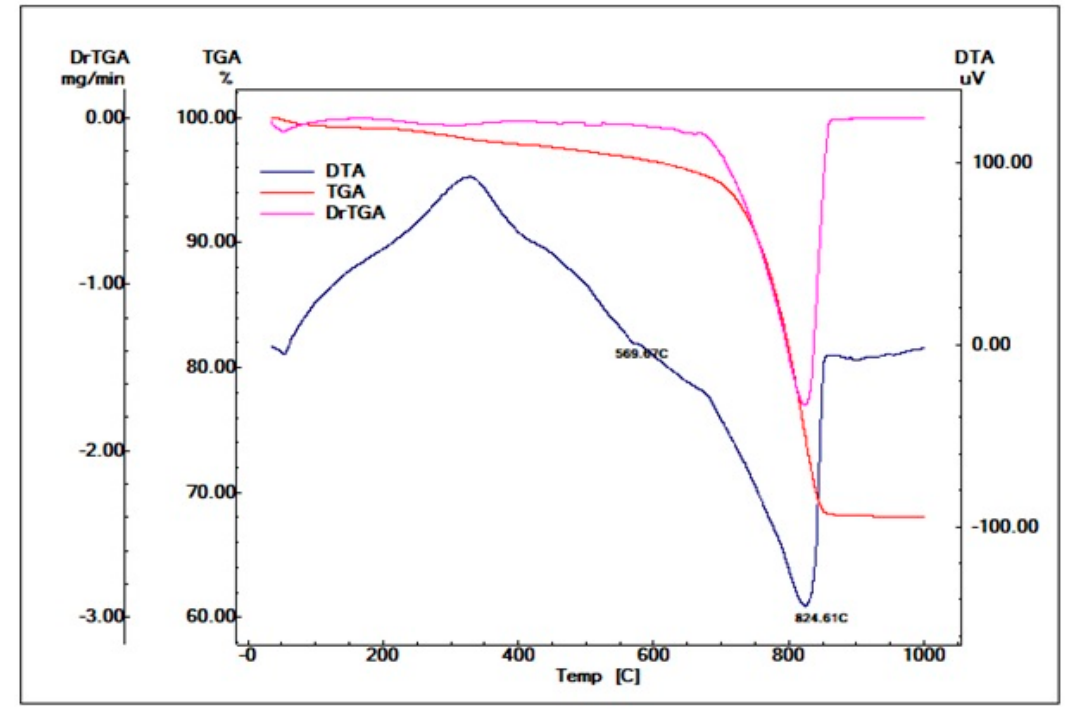
Figure 14. Thermal analysis of sample C.